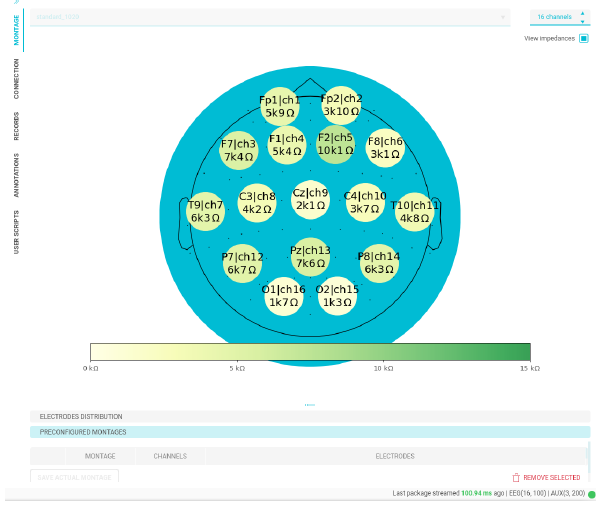
Figure 16. Interface widget for real-time impedance visualizer. OpenBCI EEG cap for 16 channels is used within our MI paradigm.